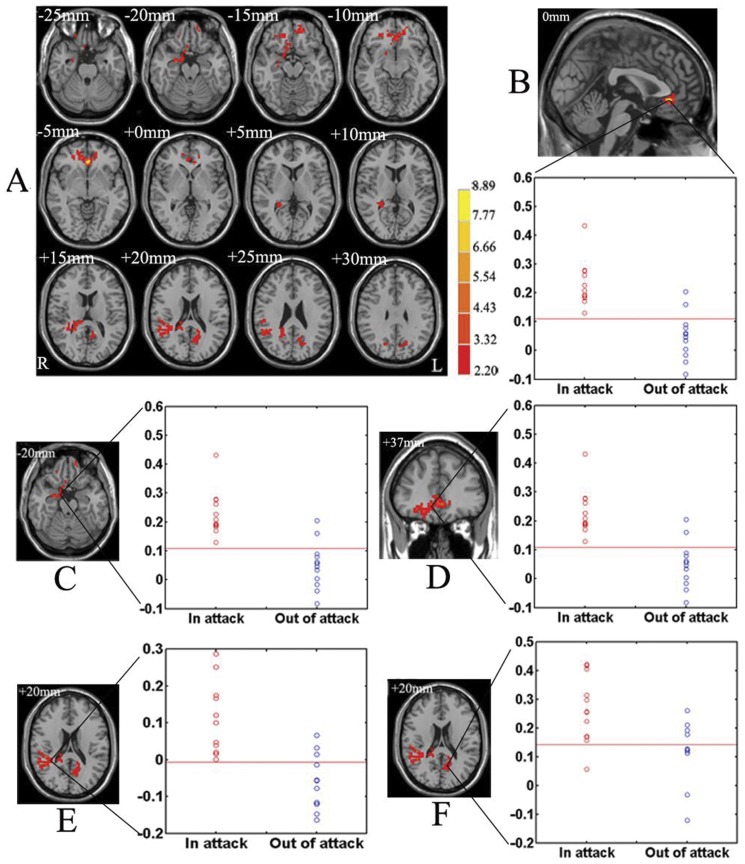
Altered functional connectivity of the hypothalamus and the mean functional connectivity with the right hypothalamus for each subject in CH patients during the ‘in attack’ periods vs.those during the ‘out of attack’ periods. (A) Brain regions showing significantly increased functional connectivity with the right hypothalamus in CH patients during the ‘in attack’ periods in comparison to those during the ‘out of attack’ periods, thresholded at P<0.05, corrected by Monte Carlo simulations. Color bar indicates the t-score. R, right; L, Left. Brain regions in three dimensions including the bilateral anterior cingulate cortex (B), the right parahippocampal gyrus, hippocampus and amygdale (C), and the bilateral frontal cortex (D), together with other brain regions such as the right angular, supramarginal gyrus, insula, superior temporal gyrus and precuneus (E), and the left precuneus, parietal lobe, posterior cingulate cortex and occipital lobe (F) showing the corresponding scattergram of the mean functional connectivity with the right hypothalamus for each subject in CH patients during the ‘in attack’ and ‘out of attack’ periods.